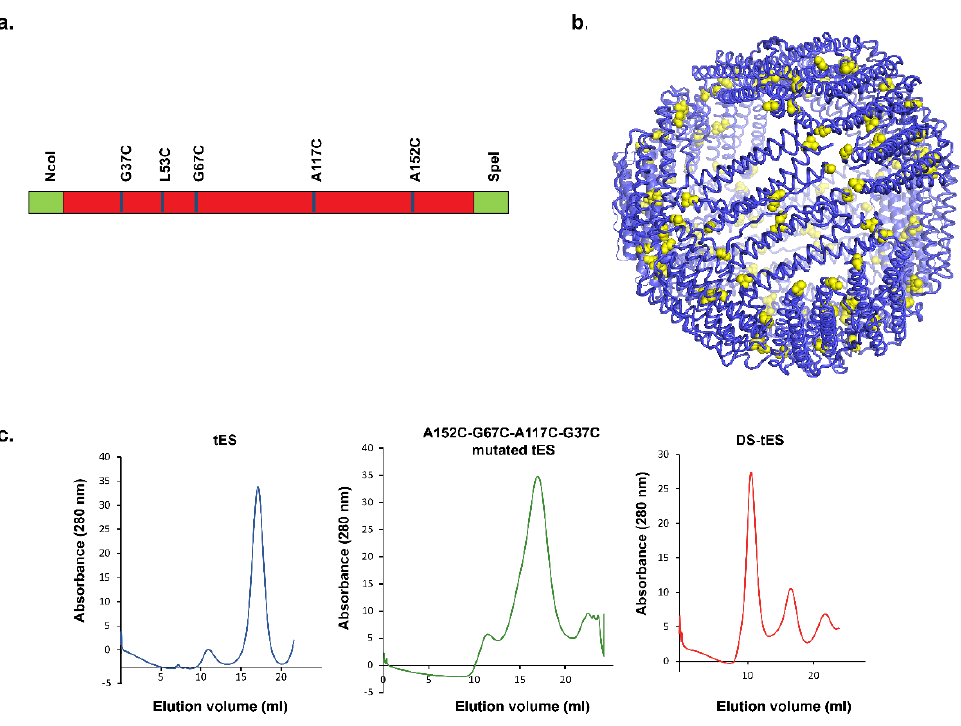
Figure 1. ( a ) Schematic representation of DS-tES construct with six point mutations and restriction sites. ( b ) PyMOL representation of DS-tES with all the point mutations (yellow represents the cysteine residues). ( c ) Size-exclusion chromatography of tES, A152C-G67C-A117C-G37C mutated tES, and DS-tES at pH 4.0.